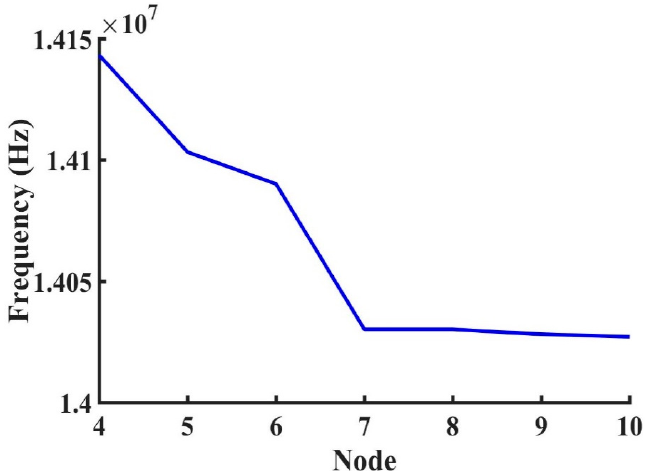
Figure 4. Effect of node density (mesh node in a wavelength). Figure 4. E ff ect of node density (mesh node in a